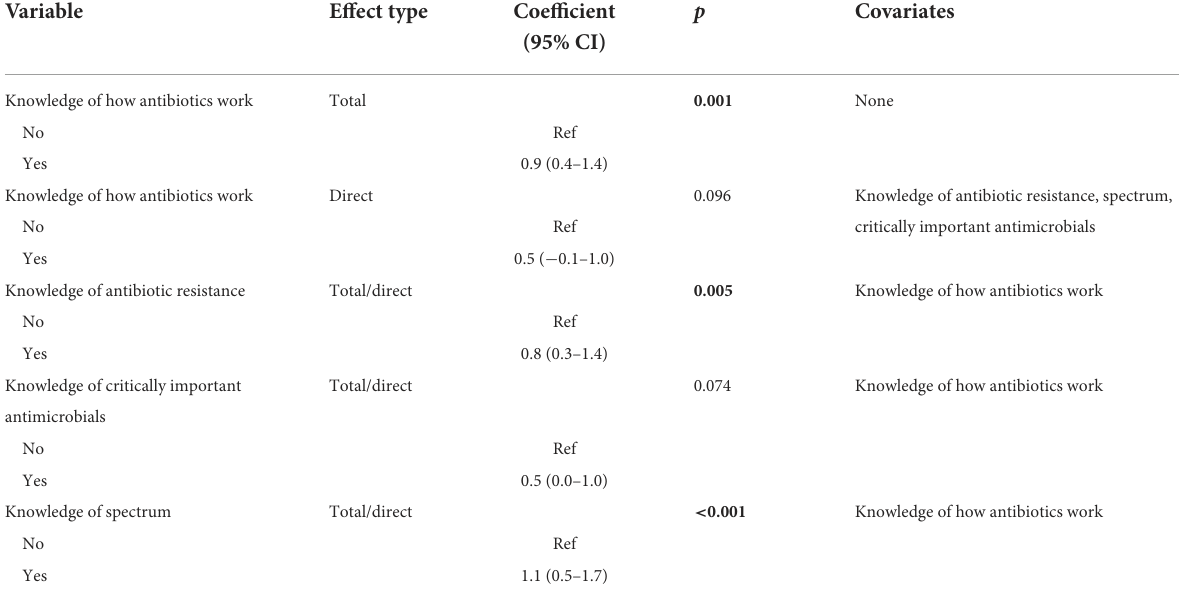
TABLE 6 Estimated coefficients for the total and direct effects of key knowledge variables on attitude score derived from a series of linear regression models.